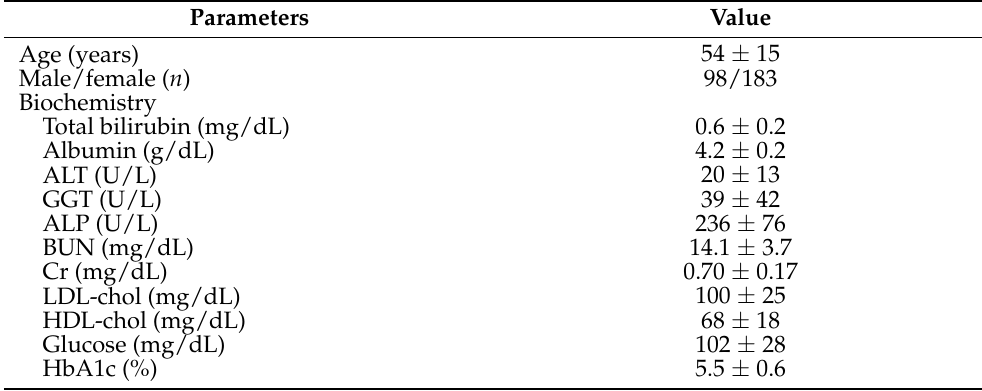
Table 1. Laboratory findings of 281 patients with hepatic hemangiomas.